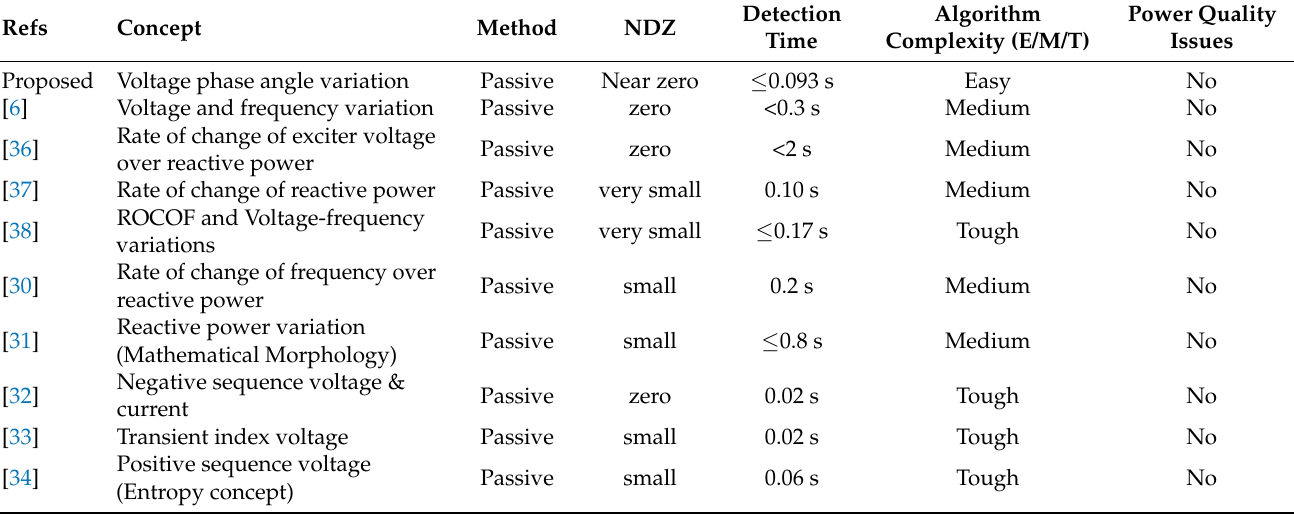
Table 4. Comparison of existing islanding detection strategies.